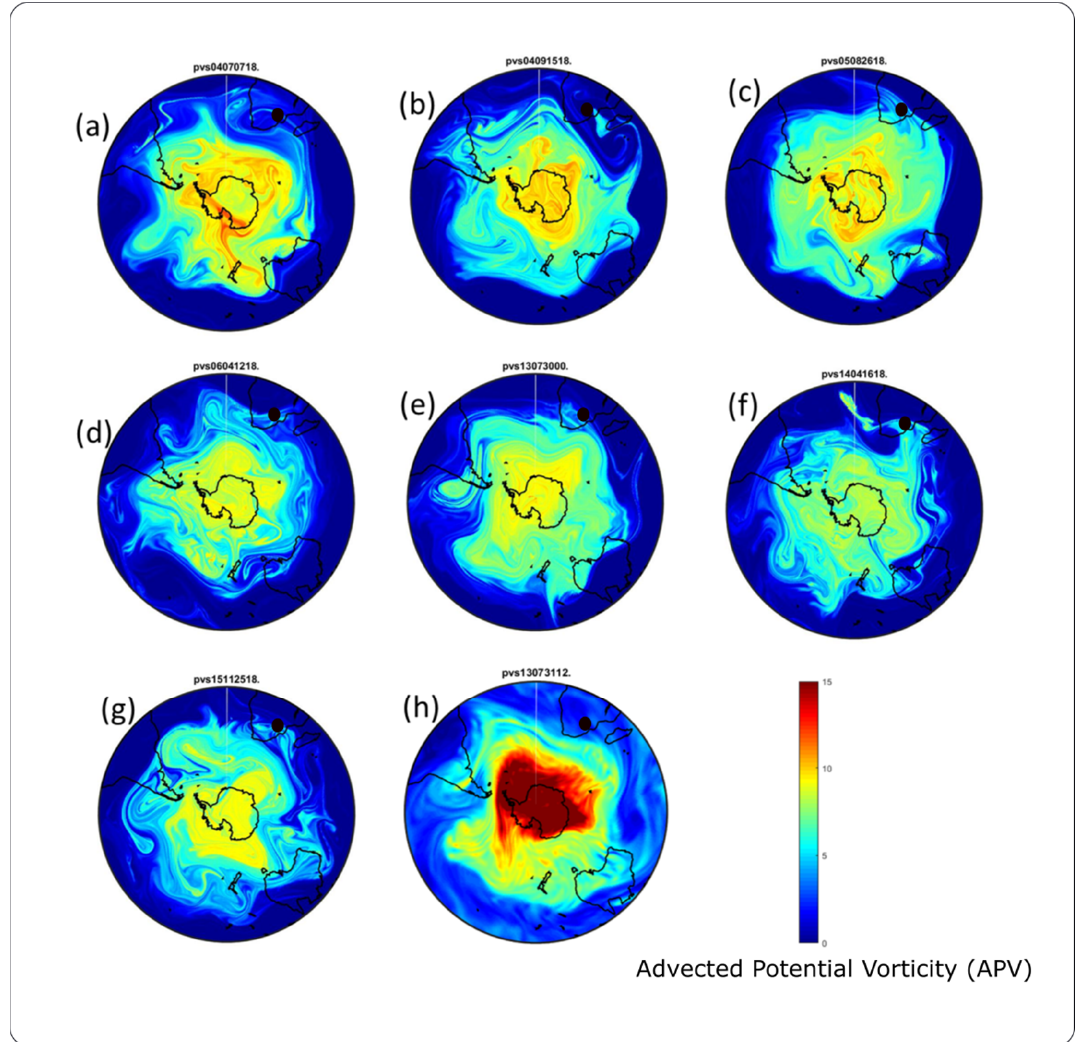
Figure 11. Advected Potential Vorticity (APV) maps assimilated with the MIMOSA model for the 350 K isentropic level (in PVU) and for 07 July 2004 ( a ), 15 September 2004 ( b ), 26 August 2005 ( c ), 12 April 2006 ( d ), 30 July 2013 ( e ), 31 July 2013 ( f ), 16 April 2014 ( g ), and 25 November 2015 ( h ). The black dot represents the location of the Irene site.